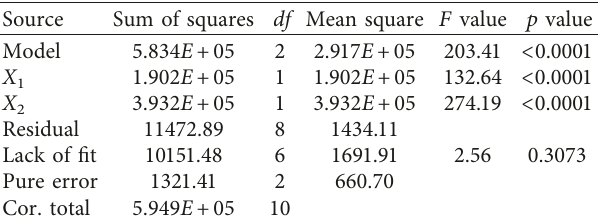
Table 9: Analysis of variance results for simplified model for re- sponse variable R 2 .